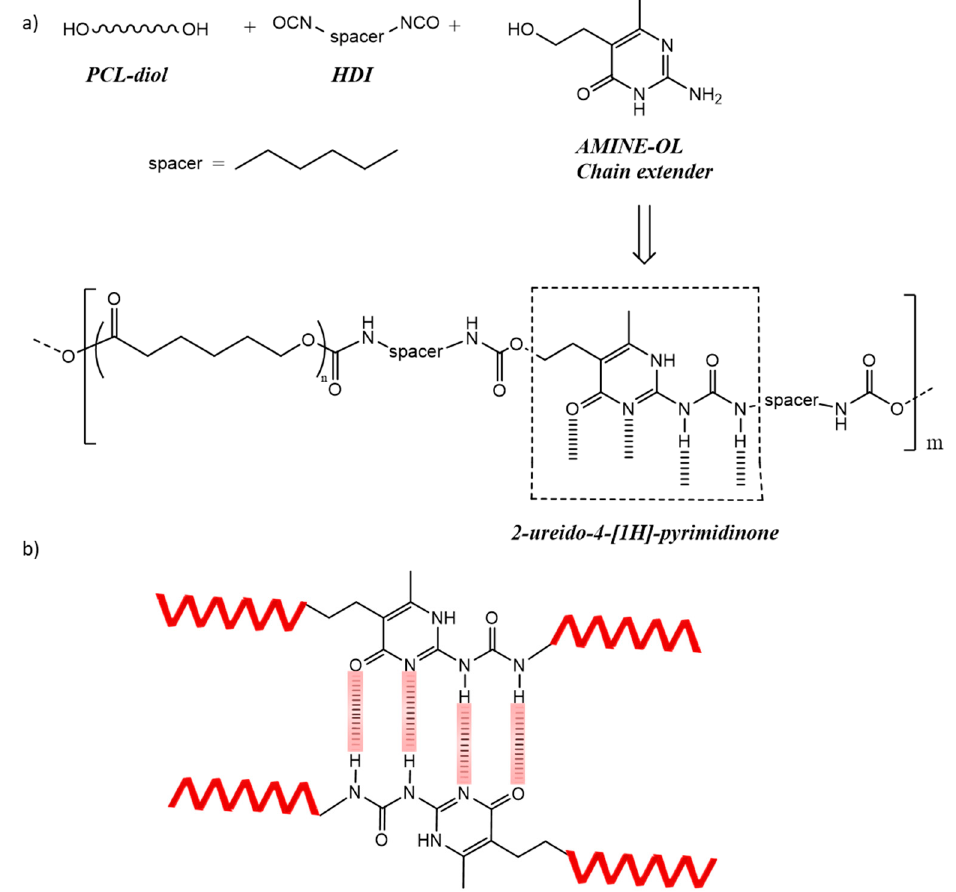
Figure 1. ( a ) Reaction scheme for PCL-based polyurethanes. ( b ) Schematic representation of the UPy network